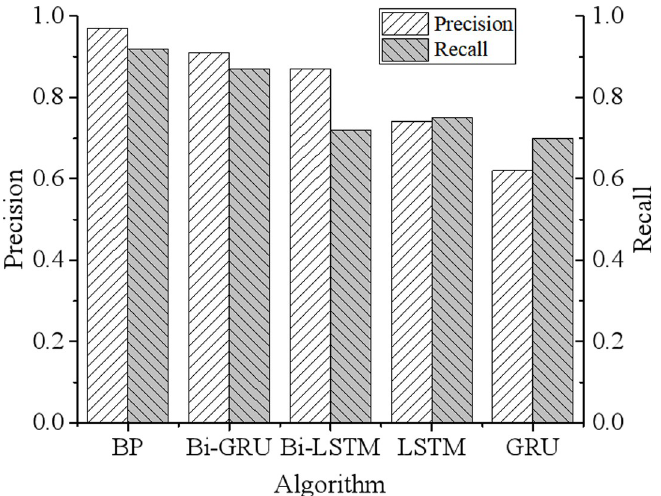
Fig 12. Comparison of salary forecast results of different NN